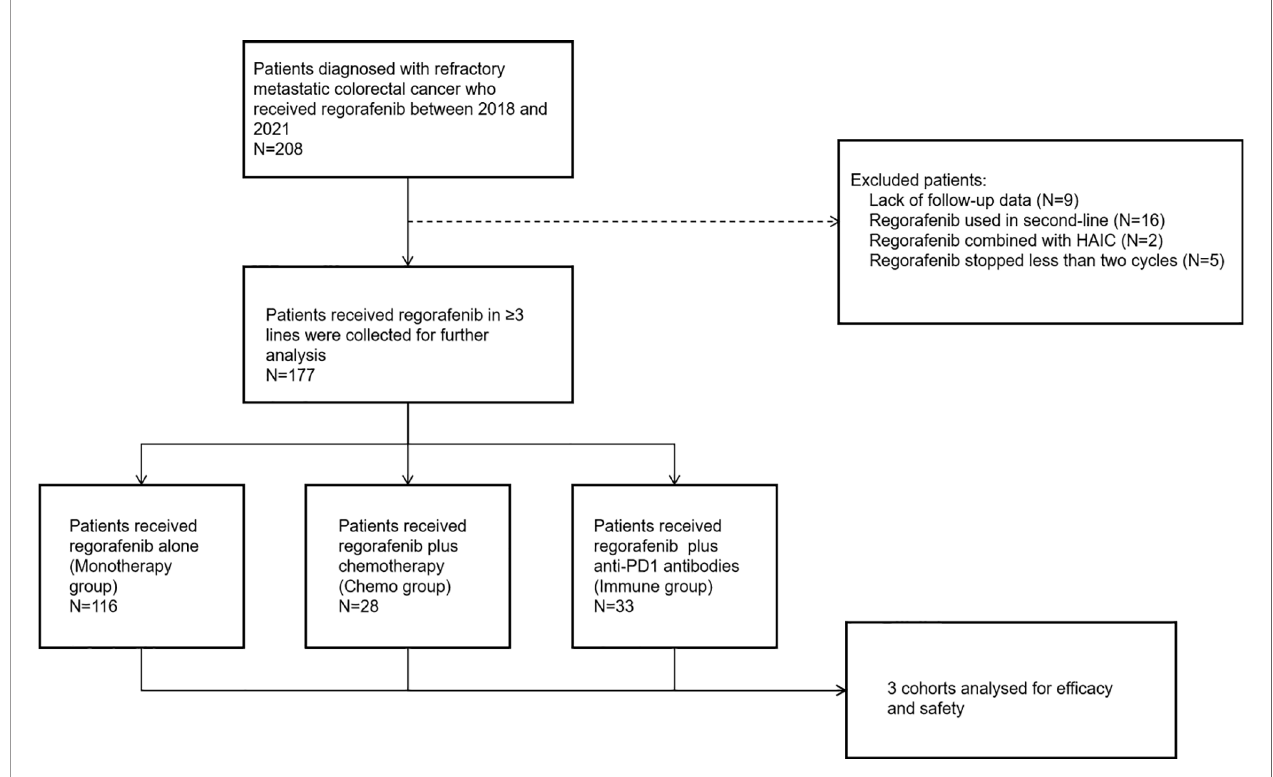
FIGURE 1 | The pro fi le of the present